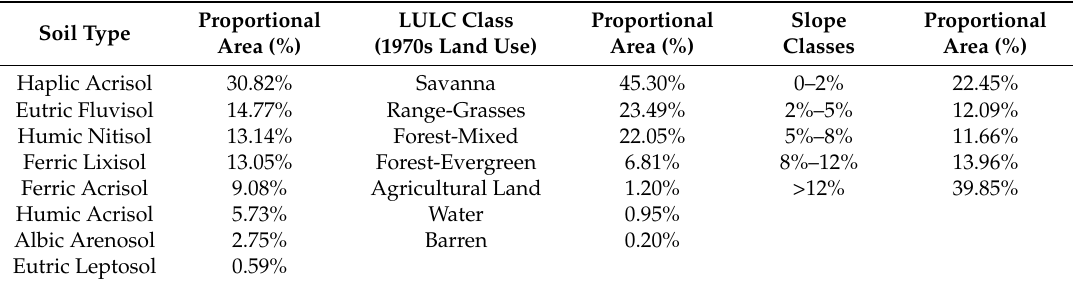
Table 3. Final spatial coverage with the different soil types, LULC classes, and slope classes of the study area after defining the HRUs.